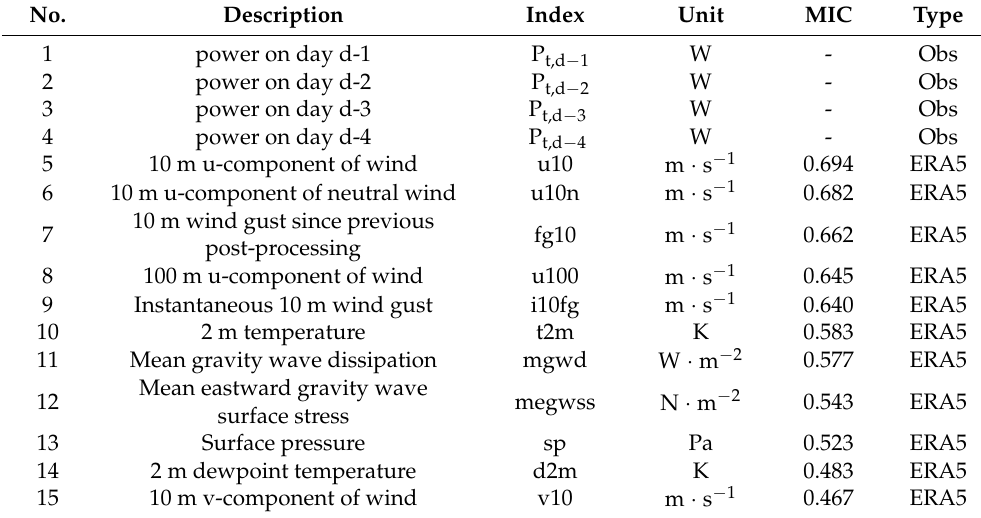
Table 4. List of input data for